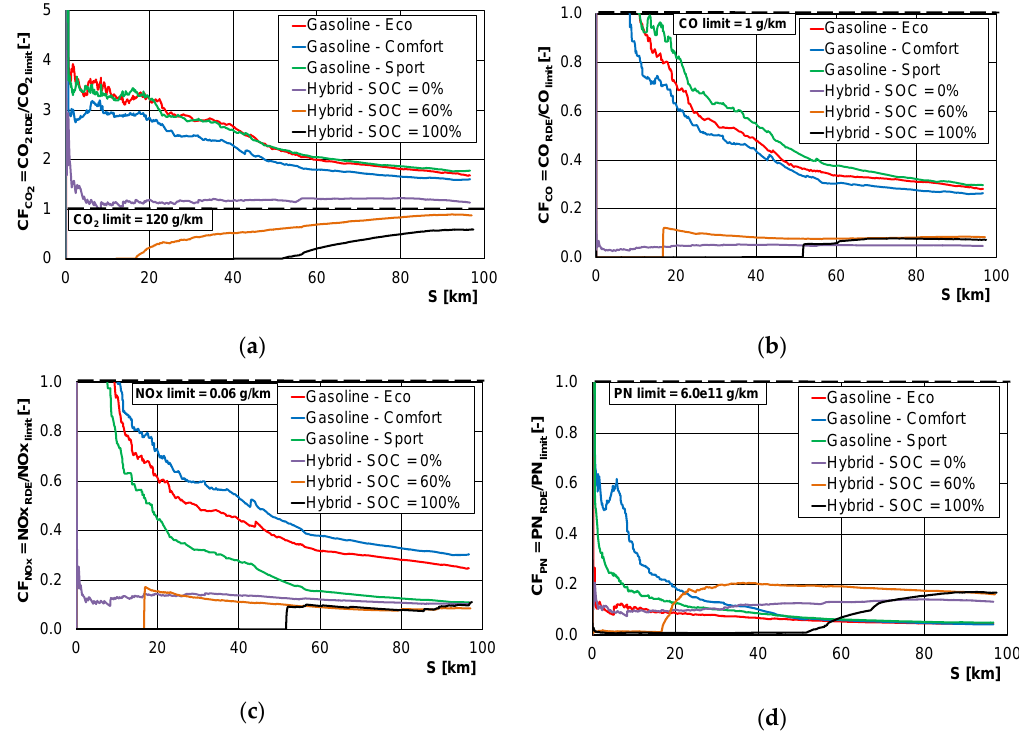
Figure 8. Comparison of the emission conformity factors (CF) for selected exhaust components during the tests: ( a ) carbon dioxide, ( b ) carbon monoxide, ( c ) nitrogen oxides, and ( d ) particle number.